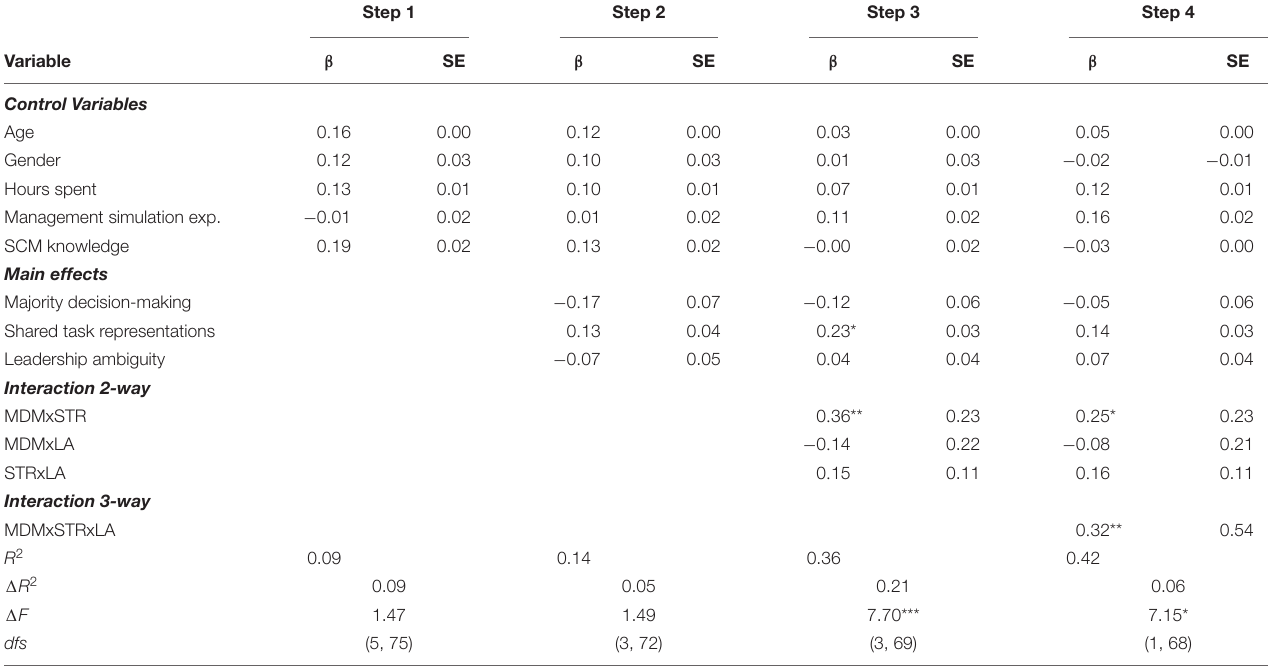
TABLE 2 | Hierarchical Regressions with Dependent Variable Team Performance (ROI).